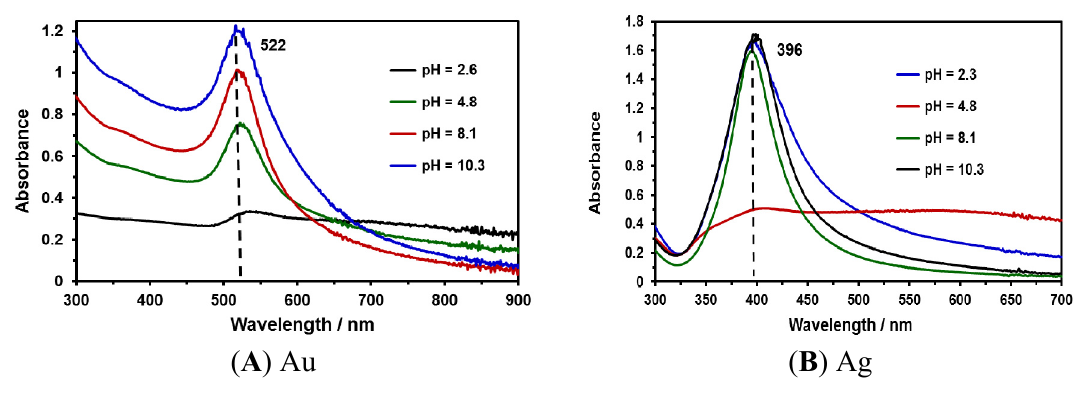
Figure 5. UV-Vis absorption spectra of NPs colloids after synthesis at various